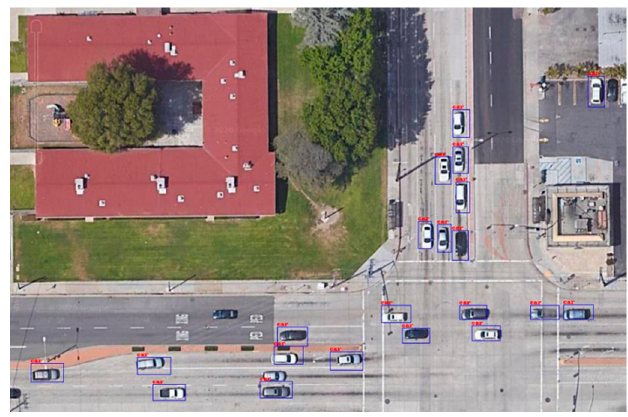
Figure 18. The detection result of a clear remote sensing image of Los Angeles.